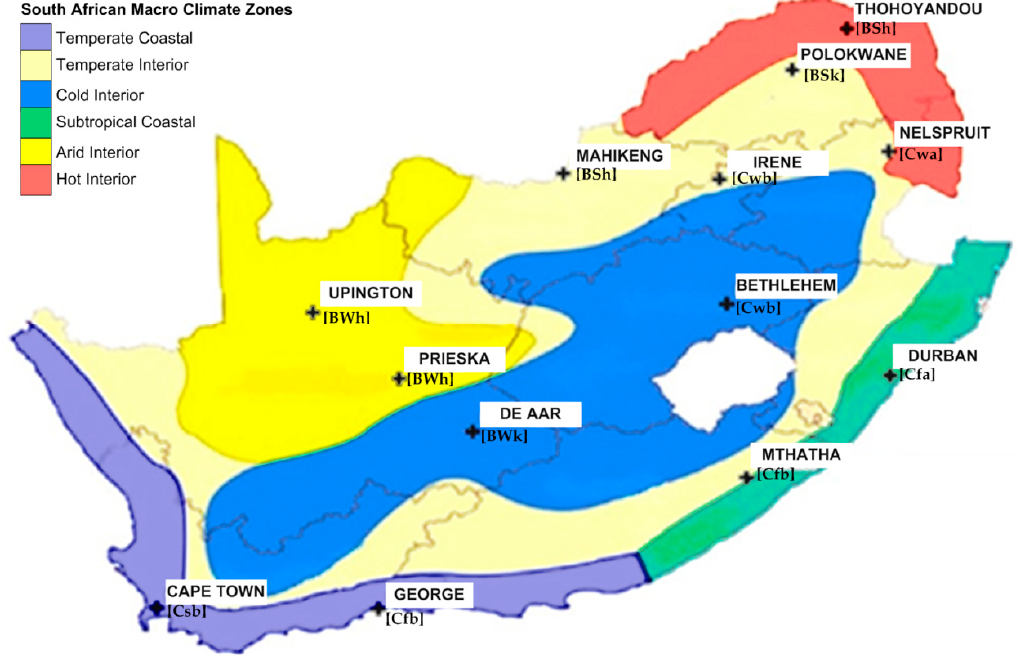
Figure 1. Depiction of the distribution of research locations in South Africa’s six macroclimate regions (From [26,33,37]). Table 1. Study locations: Latitude, longitude, altitude, and GHI observation period. Station